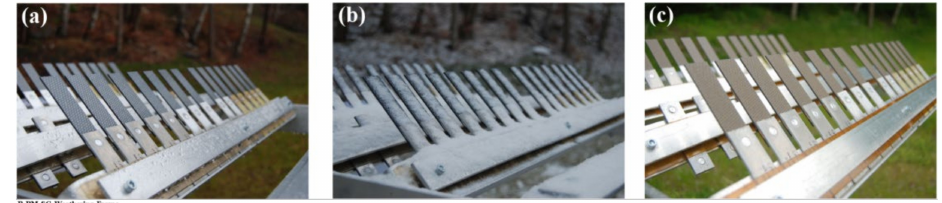
Figure 14. Outdoor natural weathering of the AA2024-T3 / CF-PPS friction spot joints; specimens ( a ) during the first month, ( b ) during the third month, and ( c ) during the sixth month showing the discoloration of the composite.